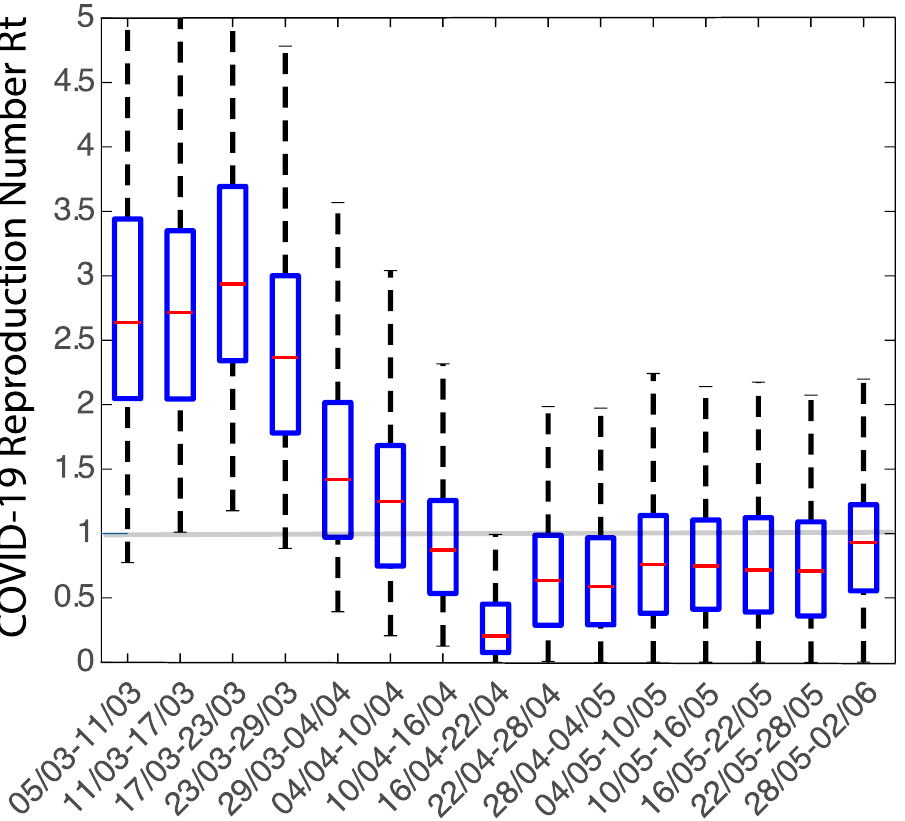
Figure 10. Median value (red) and 95 % credible intervals (box) for the posterior distributions of the effective reproduction number in metapopulation compartmental model 2, for the period between 05/03/2020 and